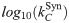
Parameter distributions for the kinetic parameter log10(kCSyn) after a bootstrap parameter estimation with n = 1000.